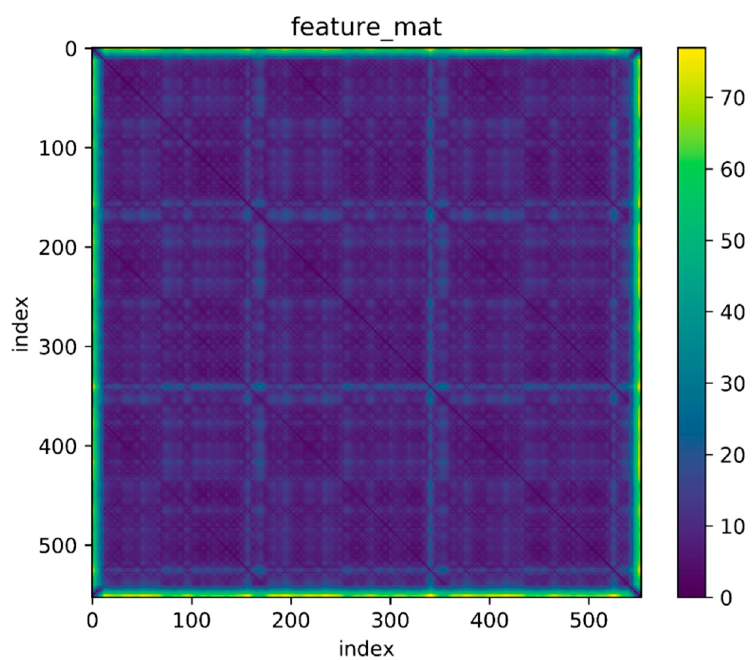
Figure 4. Distance of feature.